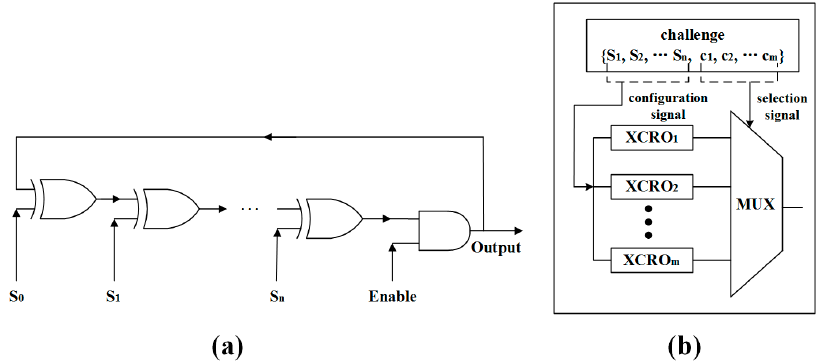
Figure 5. ( a ) Architecture of an XOR-gate-based configurable RO ( b ) Challenge signals of an XOR-gate-based configurable RO PUF [12].